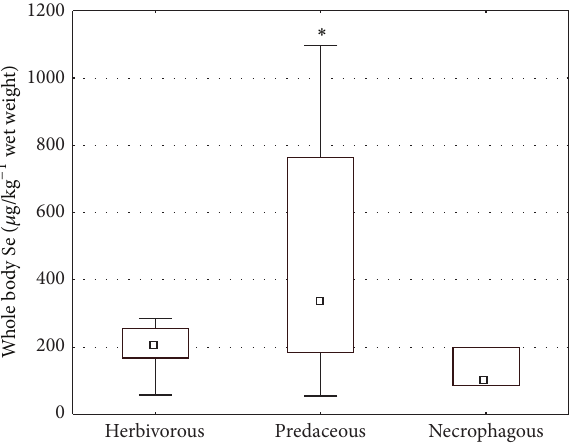
Figure 1: Histogram showing log-normal distribution ( 𝜒 2 = 3 ,647, 𝑃 = 0 ,1614) of Se concentration data from 50 samples of insects collected from the Dniester River Valley. Data are individual sample values.